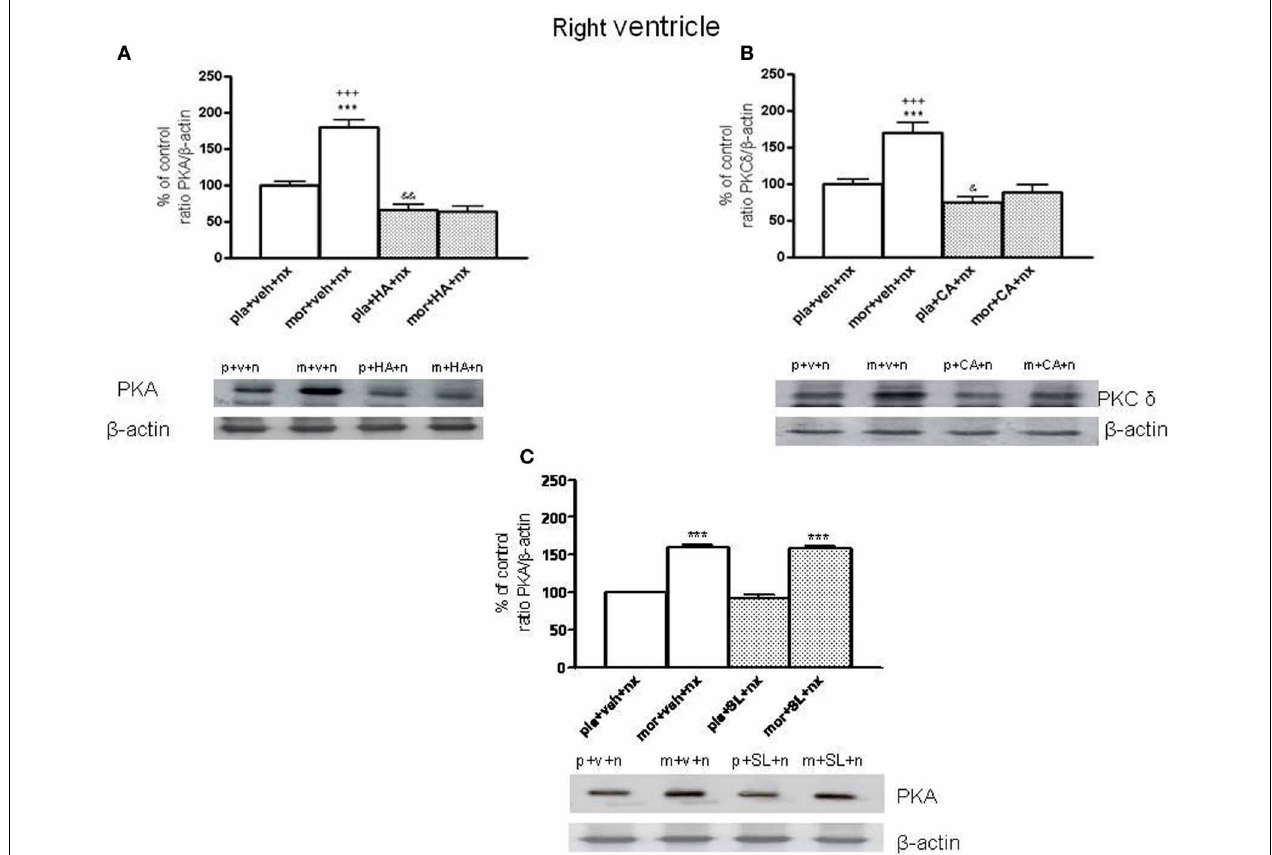
FIGURE 2 | Inmunoblots of PKA (A) and PKC δ (B) in right ventricle from placebo (pla, p)- or morphine (mor, m)-dependent rats after naloxone-precipitated withdrawal in vehicle (veh, v)-infused rats and in animals chronically administered with HA-1004 (HA) or Calphostin C (CA). Animals received subcutaneous implantation of placebo or morphine (75mg) pellets for 7 days and concomitantly were infused with vehicle, HA or CA. On day 8, rats were decapitated 90min after naloxone (nx, n.) administration in presence of vehicle, HA,